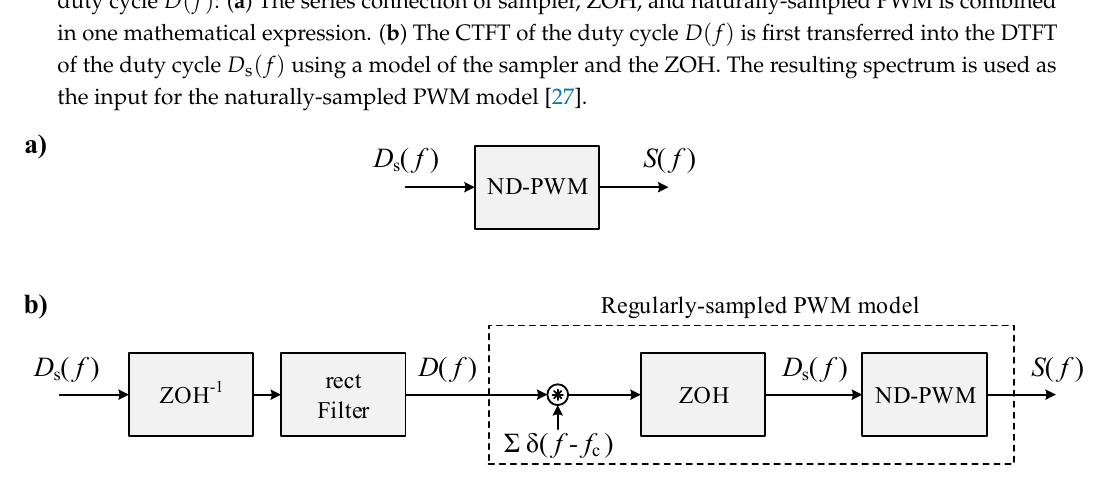
Figure 6. Equivalent methods representing regularly-sampled PWM when the input is the DTFT of the duty cycle D s ( f ) : ( a ) A block expressing naturally-sampled PWM. ( b ) An inverse ZOH and a rectangular filter the ZOH block and sampler of a regularly-sampled PWM model